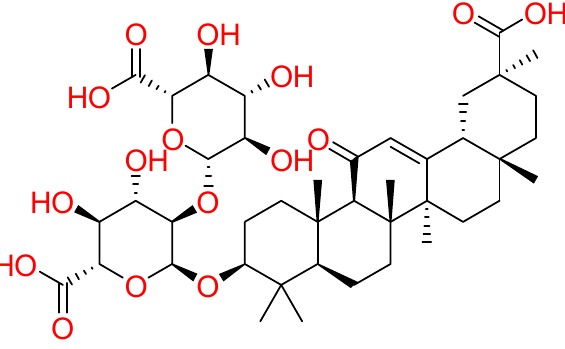
Figure 7. 2D structure of glycyrrhizin.